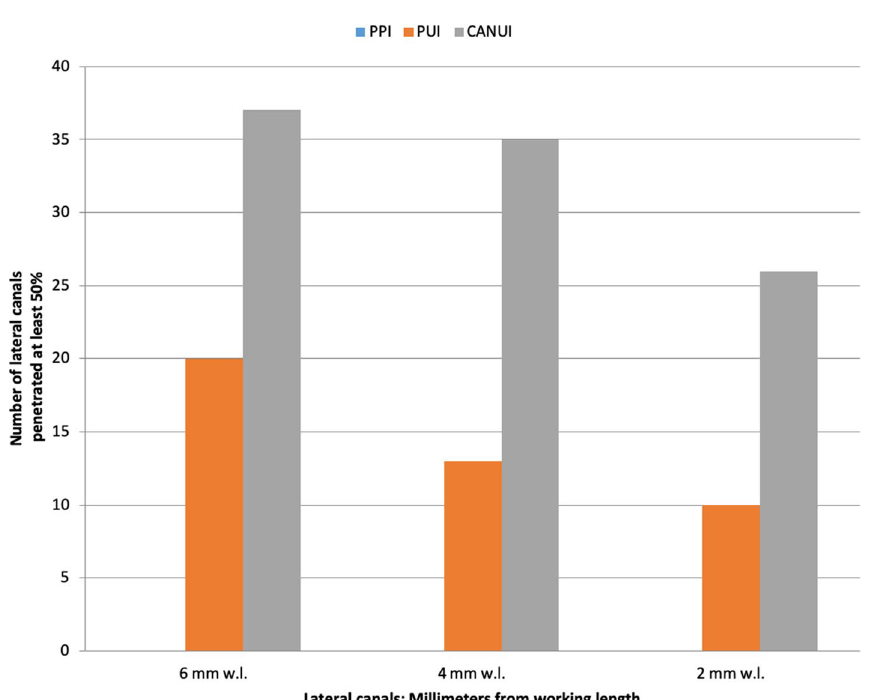
Figure 10. Graphical representation of curved root canals penetrated by the irrigation